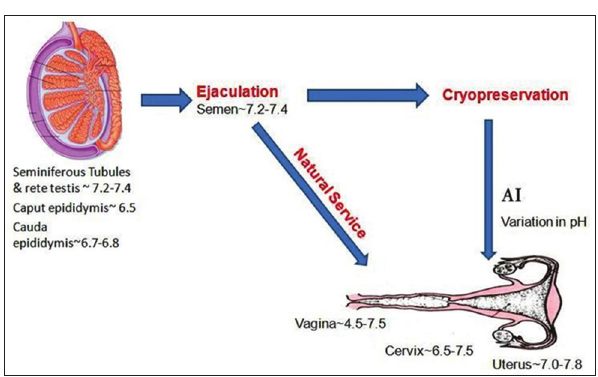
Figure-1: Different pH gradient in male and female genital tract implying a varying pH gradient for spermatozoa (Picture Courtesy: DKS, AKM and